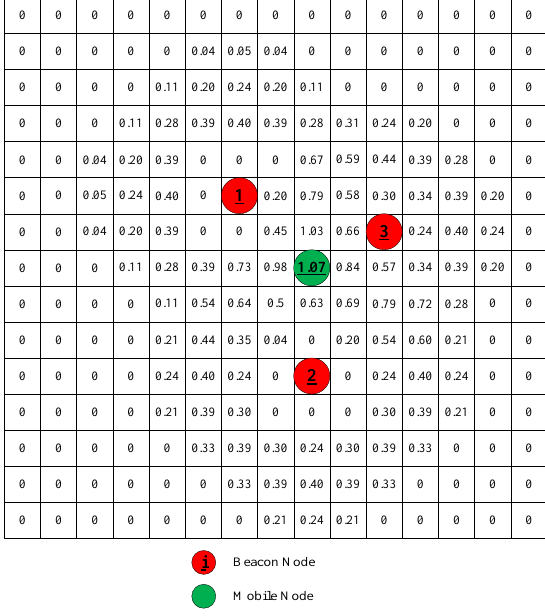
Figure 3. An example of voting process (three beacon node).